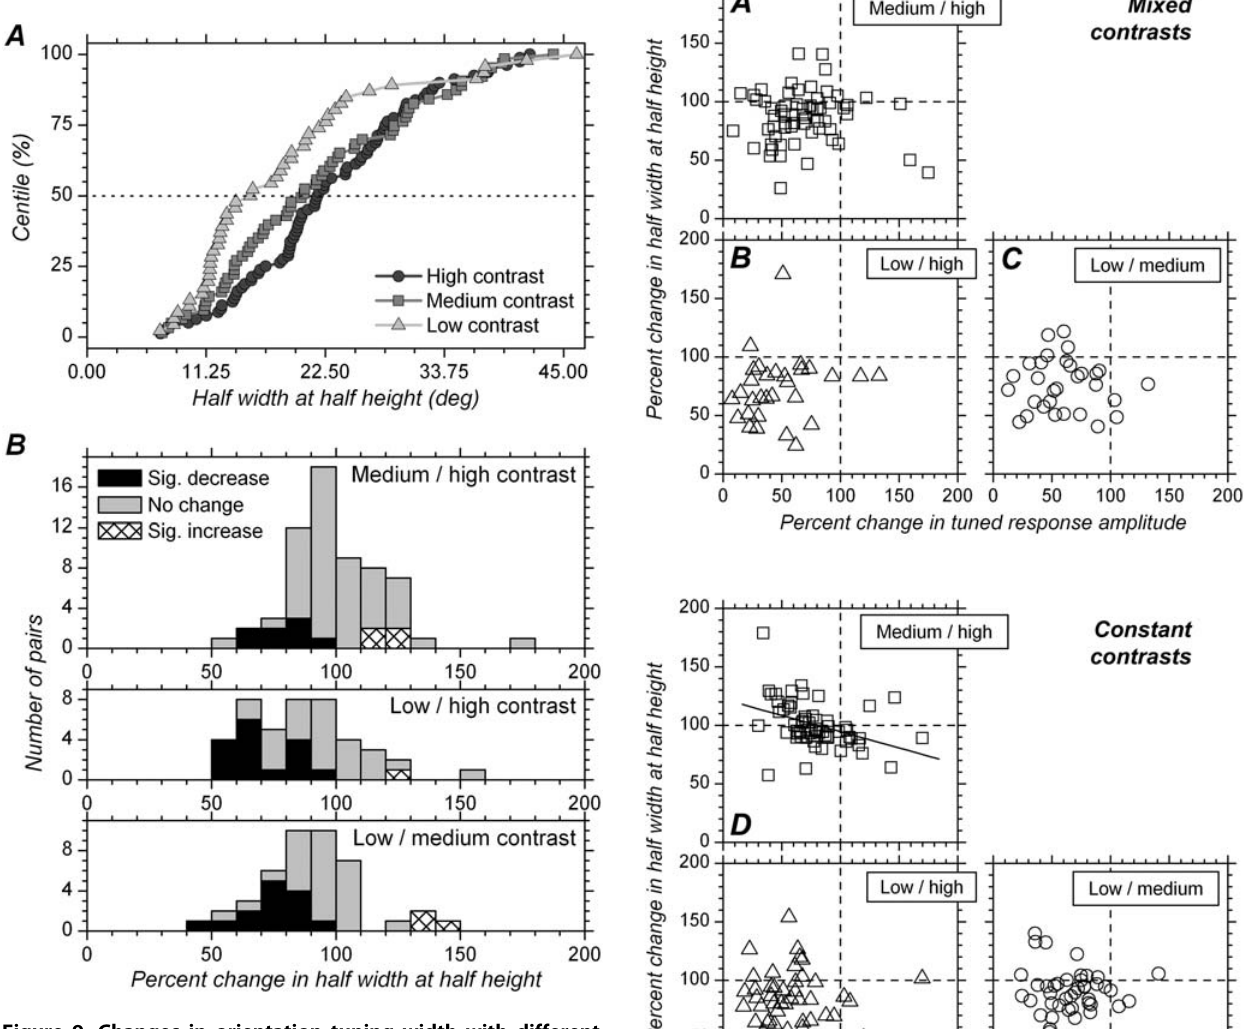
Figure 9. Changes in orientation tuning width with different contrasts for constant contrast blocks. A. Cumulative distribution of HWHH for the three different contrasts. B. Distribution of percent change in HWHH with different contrasts. Same conventions as in Figure 8. Both cumulative distributions and percent change distribu- tions show reduced effect of contrast on tuning width in the constant contrast conditions compared to the mixed contrasts condition (Fig. 8). doi:10.1371/journal.pone.0004781.g009 Figure 10. Percent change in orientation tuning width vs.